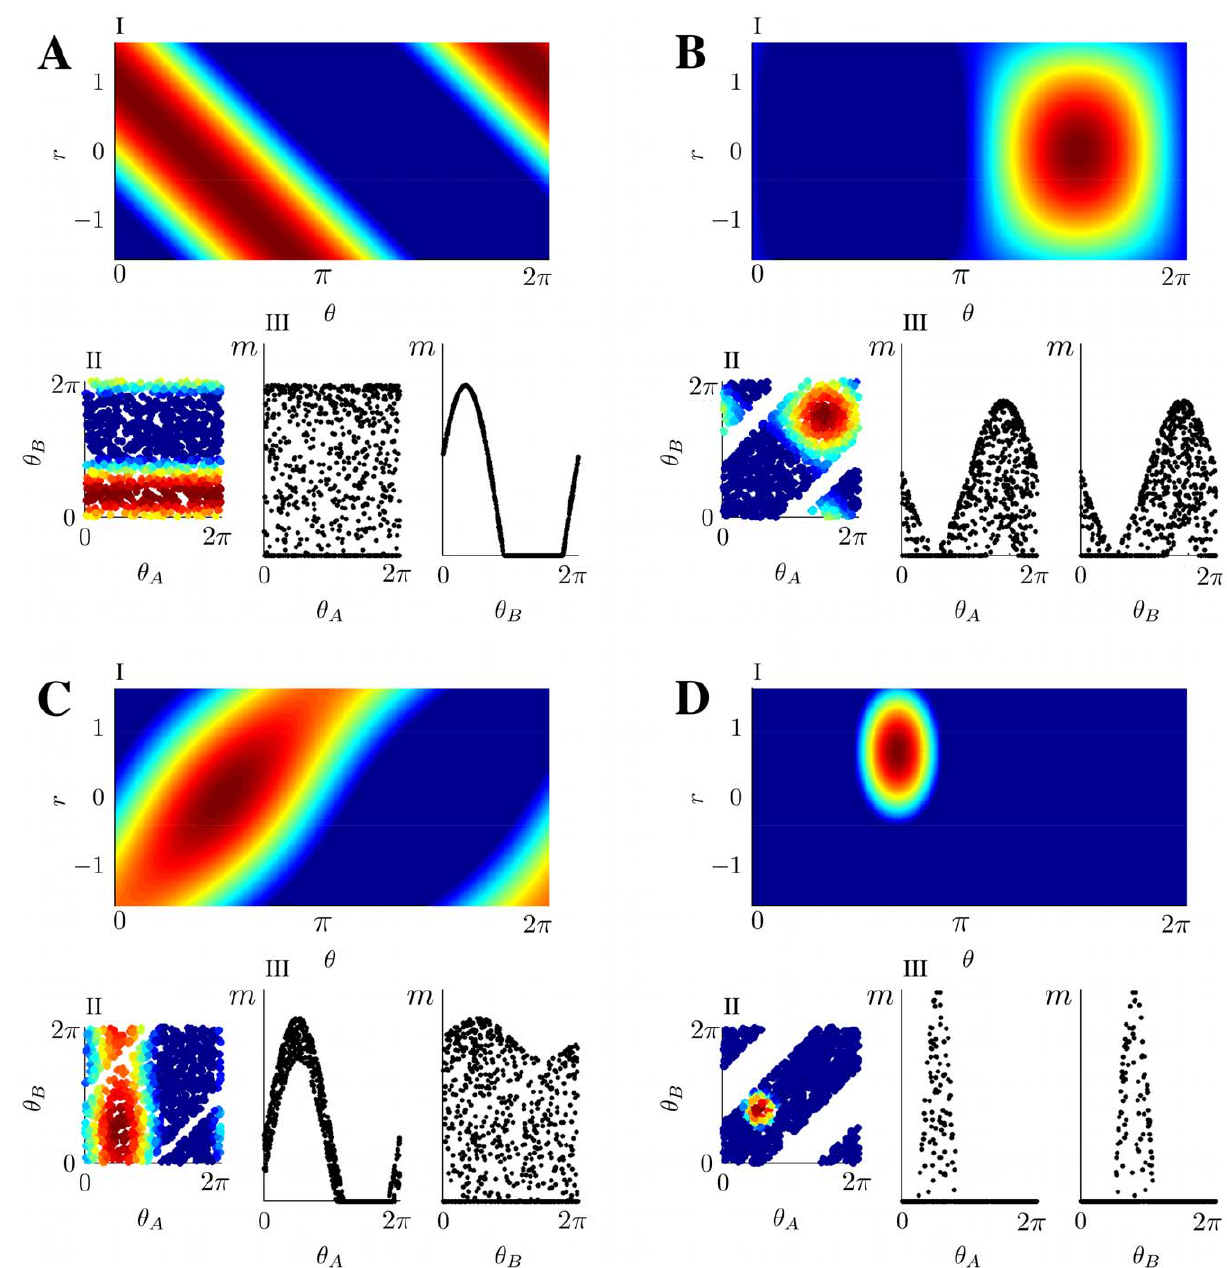
Figure 2. Network activity examples. The top plots (numbered I ) in each panel show the MF network activity (Eq. 3) in the 2D map h , r ð Þ , corresponding to different choices of the order parameters c , s , y z , y { (cid:2) (cid:3) and the distance m . Each point in the plot corresponds to a neuron with labels h , r ð Þ , the color is proportional to the activity level; warmer color represent higher activity, blue represents no activity. The activity scale is arbitrary, since it can be rescaled by a change in the external input I , without modifying the shape of the bump. Plots on the left of each panel ( II ) show the corresponding activity for a network of 1000 randomly chosen neurons in the 2D map h A , h B ð Þ , see Eq. 1. The white stripes in the plots are due to the absence of neurons with labels in those regions, imposed by the correlation between the maps. The bottom-right pairs of plots ( III ) are (cid:9) (cid:10) 4 p Activity localized in a single map, from a network projections of the activity on the individual maps. A: m ~ 1, c ~ 1, s ~ 0 : 2, y z ~ , y { ~ p (cid:9) (cid:10) 3 3 p storing uncorrelated maps. The locations of the peak activity in map A and B are y A , B ~ y z + y { . B: m ~ 0 : 8, c ~ 0, s ~ : 1, y z ~ , y { ~ 0 2 Correlated maps, activity not favoring either A or B ; since y { ~ 0 , the bump is located at the same angle in both maps. C: (cid:9) (cid:10) (cid:11) (cid:8) p p 2 p Correlated maps, activity prefers map A ( c v 0 ). D: m ~ : 6, c ~ 0, s ~{ 0 : 8, y z ~ m ~ 0 : 9, c ~{ 0 : 7, s ~ 0 : 3, y z ~ , y { ~ 0 , y { ~ 2 3 8 Correlated maps; for this smaller sized bump, the location of the activity maximum is such that y A = y B .